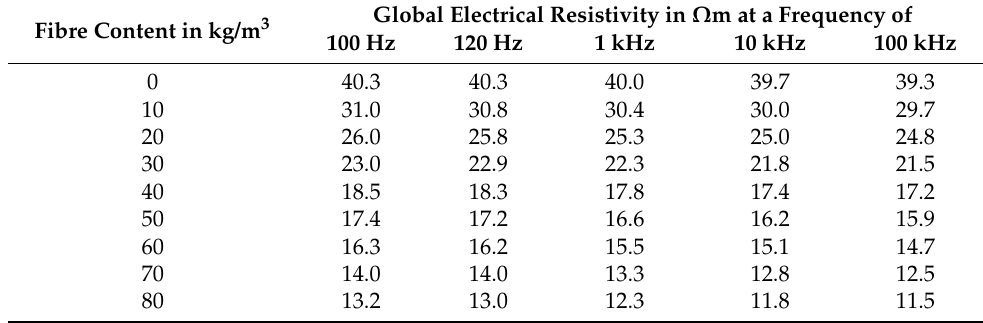
Table A17. Results of the resistivity measurements of the concrete mixture 32-60-300-35.